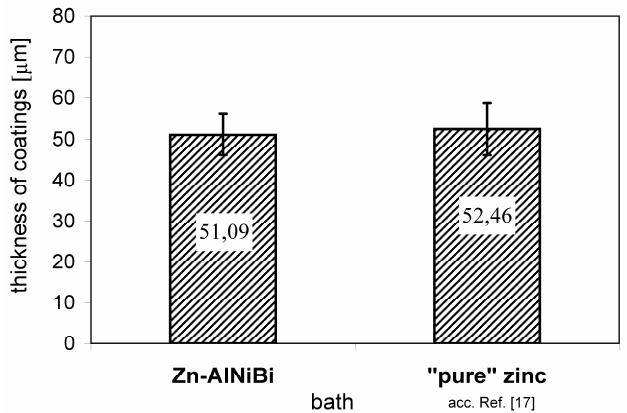
Figure 3. The coating thickness produced in Zn-AlNiBi bath and “pure” zinc bath [17] before corrosion research.